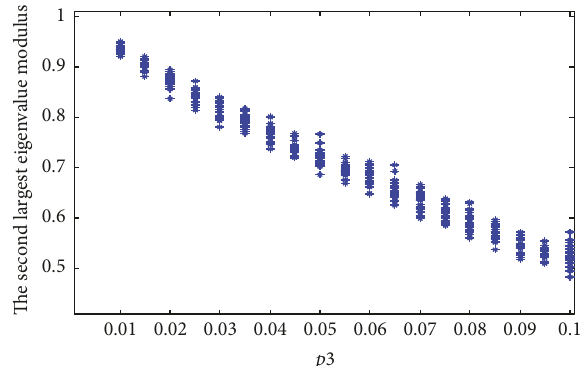
Figure 3: Example of the frequency of interaction between different subgroups impact on the second largest eigenvalue modulus, with 𝑛 = 100 , 𝑛 = 50 , 𝑝 = 0.2 , and 𝑝 = 0.4 (repeatedly calculating 30 1 2 1 2